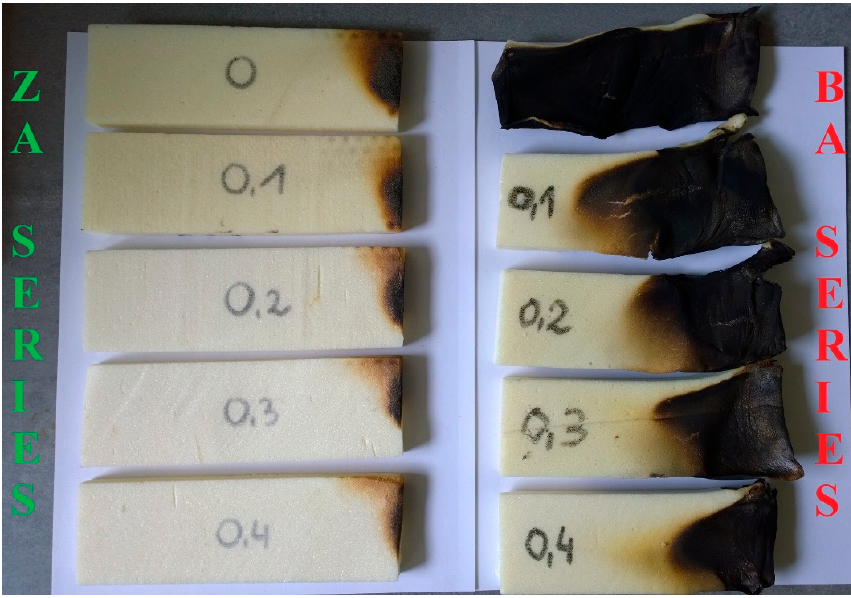
Figure 9. Appearance of ZA and BA series of foams after horizontal burning test.